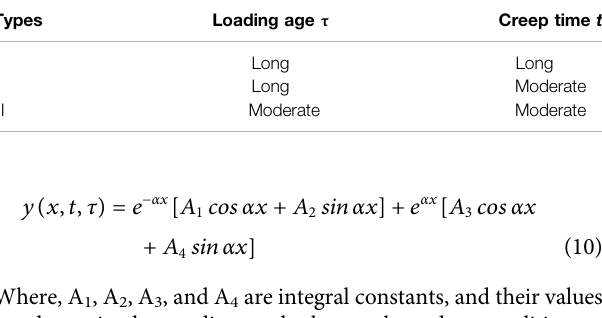
TABLE 1 | Classi fi cation of beams on elastic foundations considering